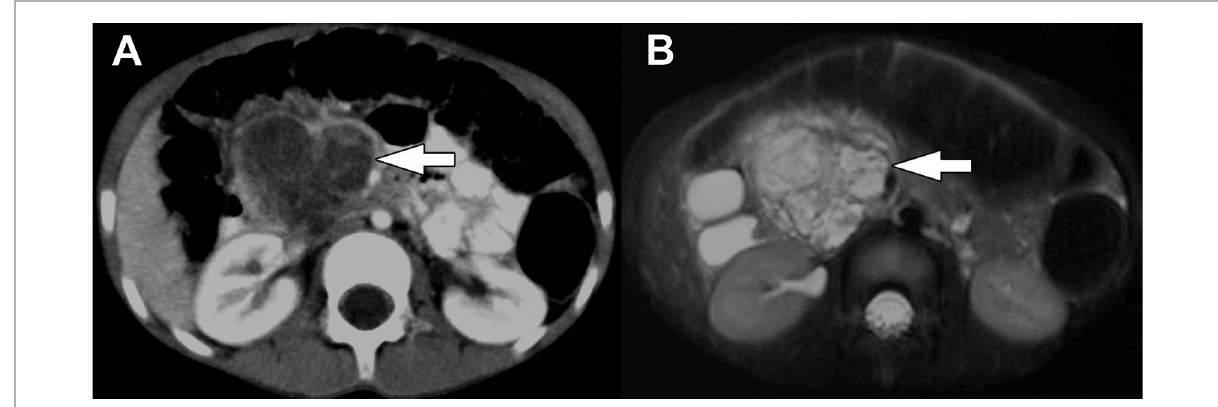
FIGURE 2 Pancreatoblastoma. ( A ) Axial CT of the abdomen obtained in the portal venous phase following intravenous contrast material administration shows a heterogeneously hypoenhancing mass arising from the head and neck of the pancreas (arrow). ( B ) T2-weighted fat-saturated MRI in the same patient shows the mass (arrow) to be heterogeneously hyperintense with the appearance of internal